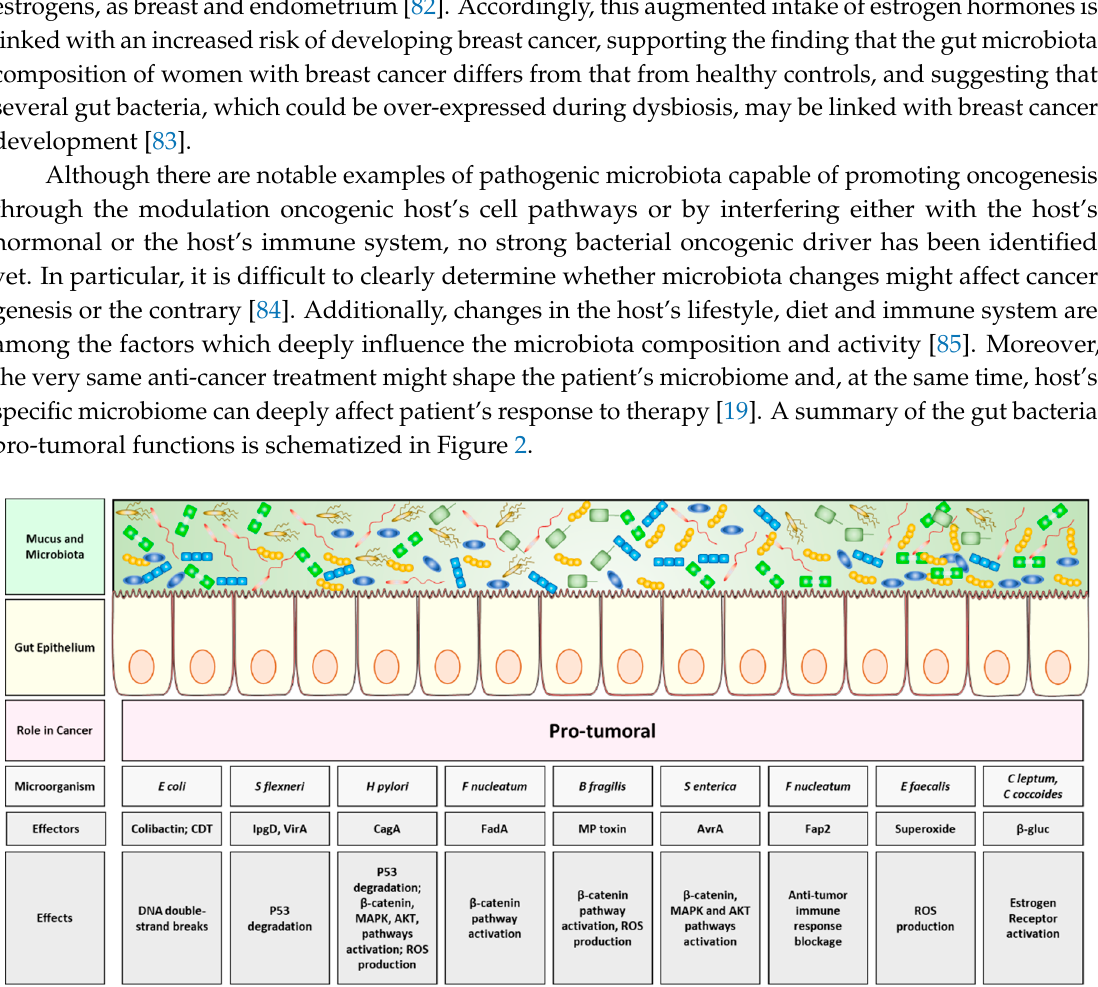
Figure 2. Pro-tumoral effects of the gut microbiota. Bacteria prominent during gut dysbiosis can secrete toxins able to interfere with host cell growth, finally predisposing the host organism to cancer development. Schematic of the intestinal layers, from top to bottom: mucus and microbiota, gut epithelium. Into the grey boxes are illustrated, from top to bottom, the microorganism species implicated in the pro-cancer process, the molecules produced and the corresponding effects induced within the host. Abbreviations: ROS, Reactive Oxygen Species; CTD, cytolethal distending toxin; IpgD, inositol phosphate phosphatase D; VirA, virulence gene A; CagA, cytotoxin associated gene A; FadA, Fusobacterium effector adhesin A; MP Toxin, metalloproteinase toxin; AvrA, avirulence protein A; β -gluc, β -glucuronidase.